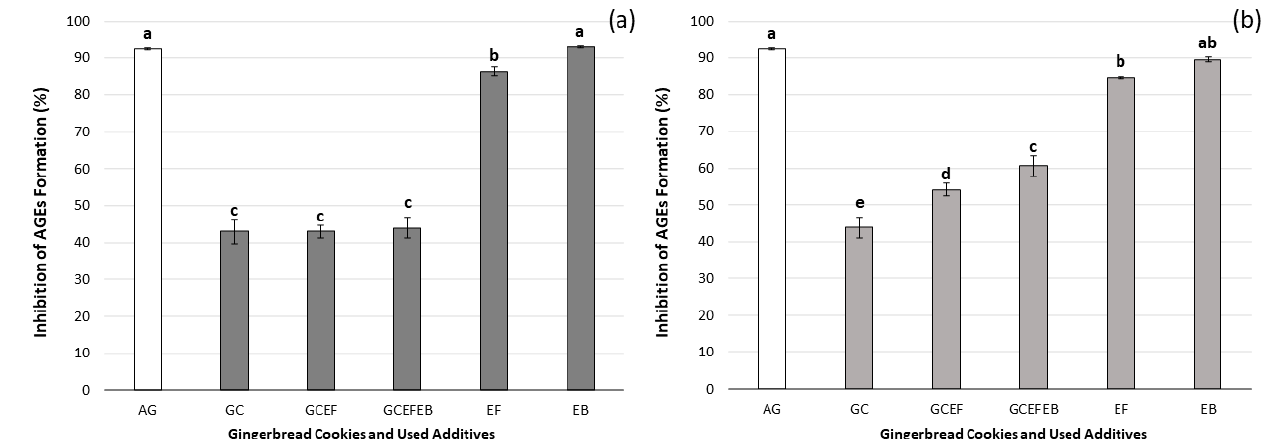
Figure 2. The inhibitory effects of gingerbread cookies covered in chocolate without additives (GC) and with elderflower dry extract (GCEF), as well as enriched with elderberry juice concentrate (GCEFEB); elderflower dry extract (EF); elderberry juice concentrate (EB); aminoguanidine solution (AG, as a positive control; 1 mM/L) against AGEs’ formation determined for free ( a ) and bound ( b ) phenolic fractions. Different letters (a–e), separately for each phenolic fraction, indicate significant differences (one-way ANOVA and Tukey’s test, p ≤ 0.05).